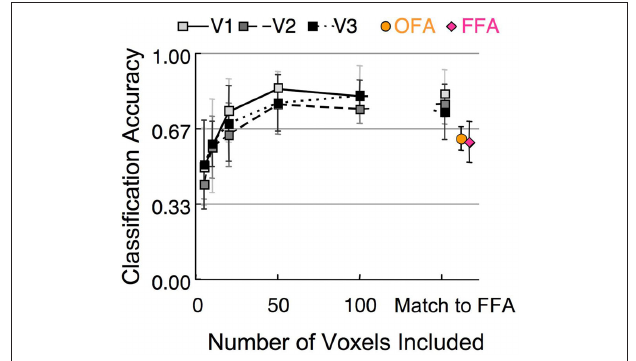
Figure 8 | Mean classification of stimulus category in experiment 1 based on different numbers of voxels in early visual cortex (V1–V3). The rightmost square symbols indicate where the number of V1–V3 voxels matched the number of voxels in the FFA ( Table 1 ). The rightmost circle and diamond symbols indicate the classification performance within the OFA and FFA. (error bars, 95%